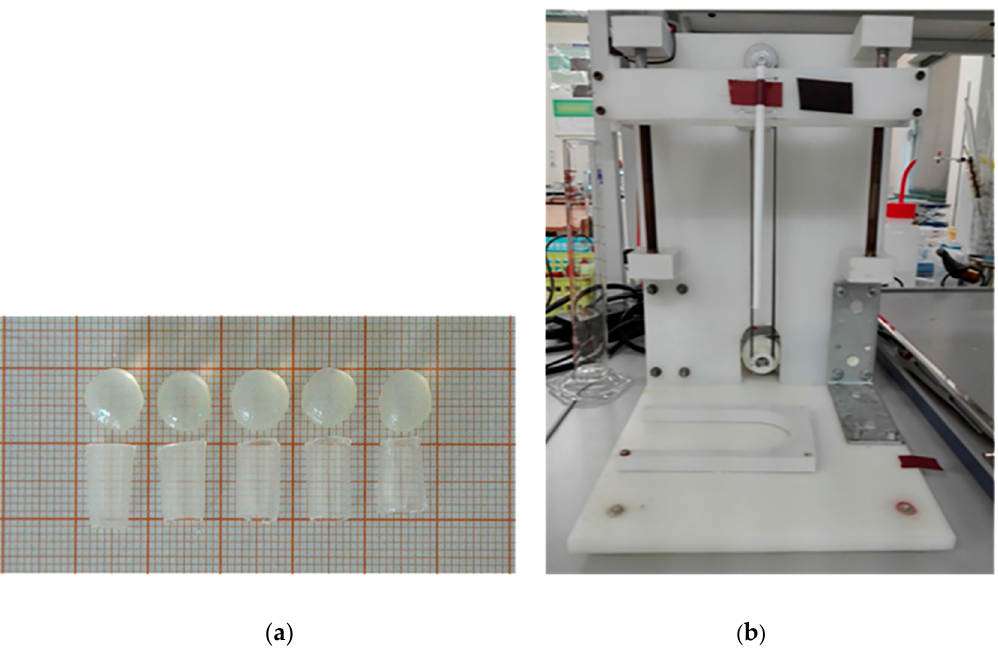
Figure 1. ( a ) Samples of hydrogel material; ( b ) station for forming hydrogel material in the shape of tubes.